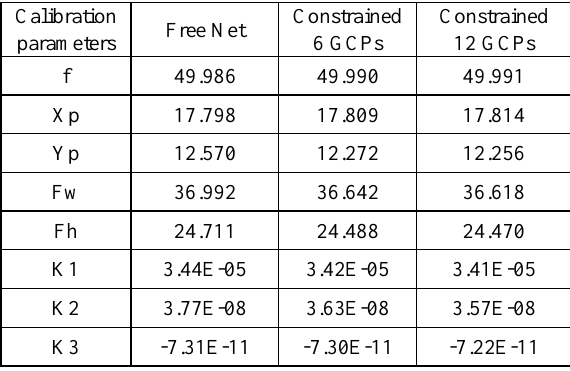
Table 4. Camera calibration parameters calculated by Photoscan